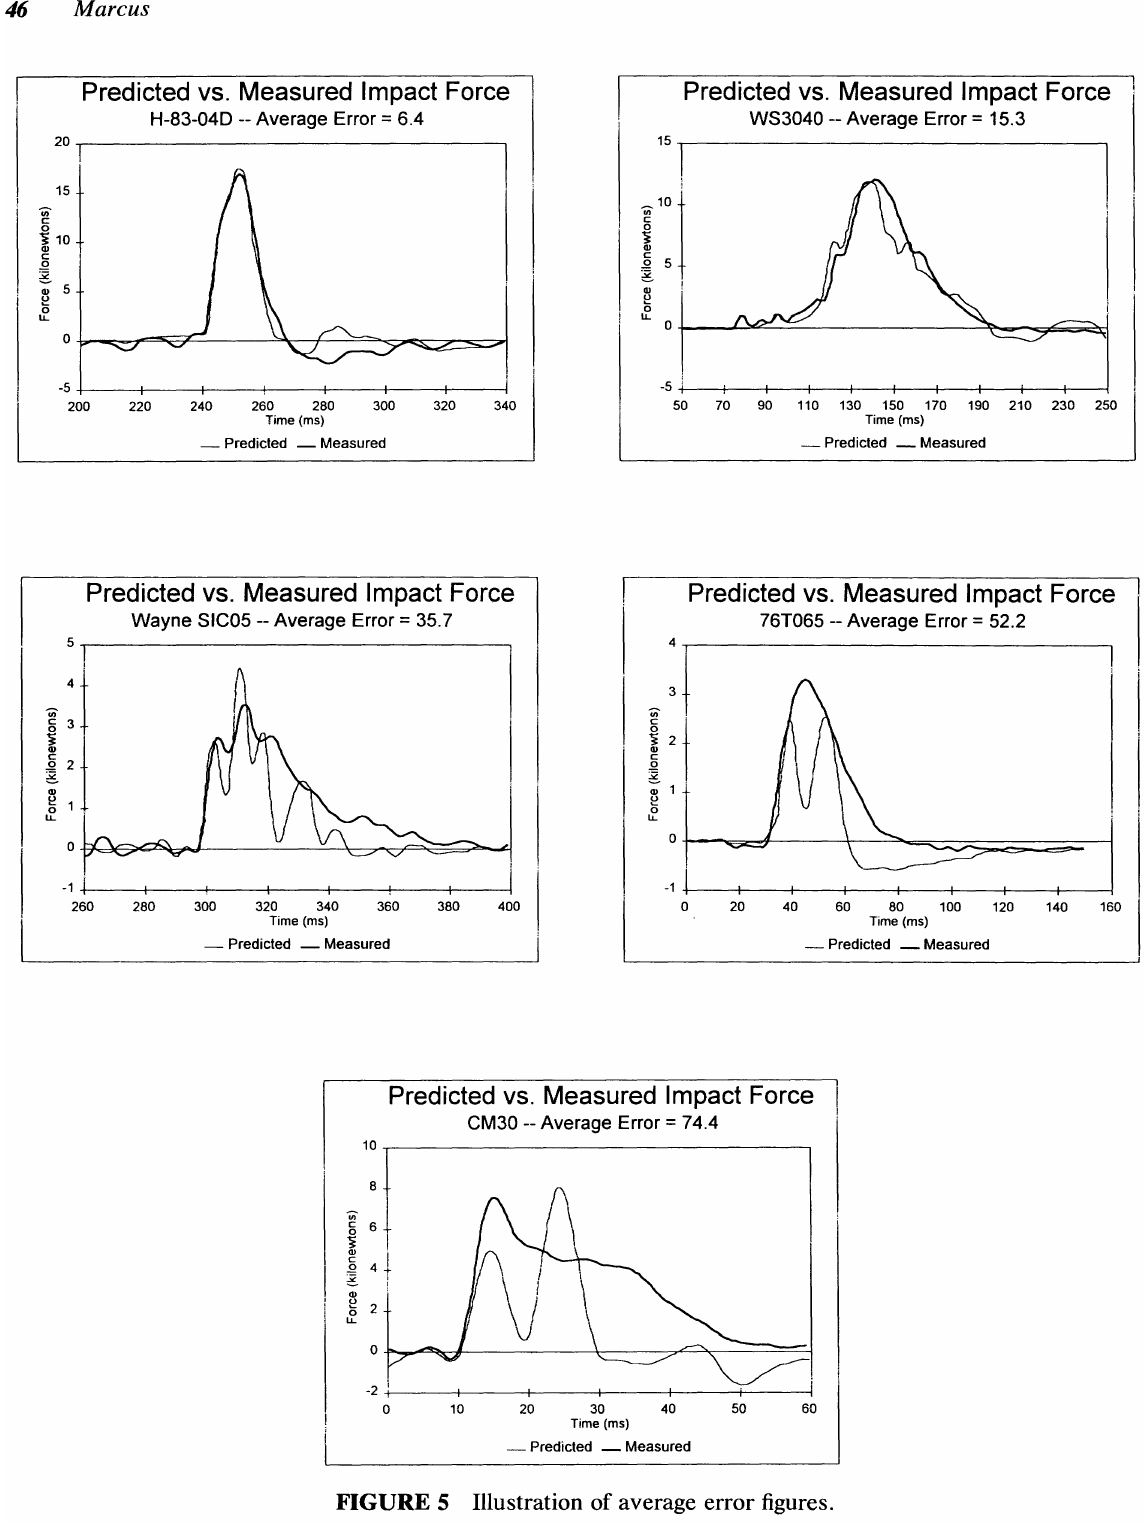
FIGURE 5 Illustration of average error